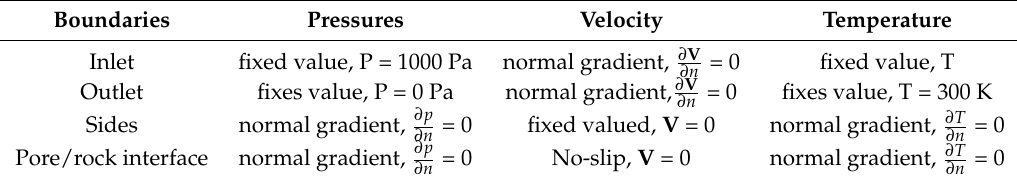
Figure 4. A schematic of the flow configuration at pore scale. Table 2. Boundary